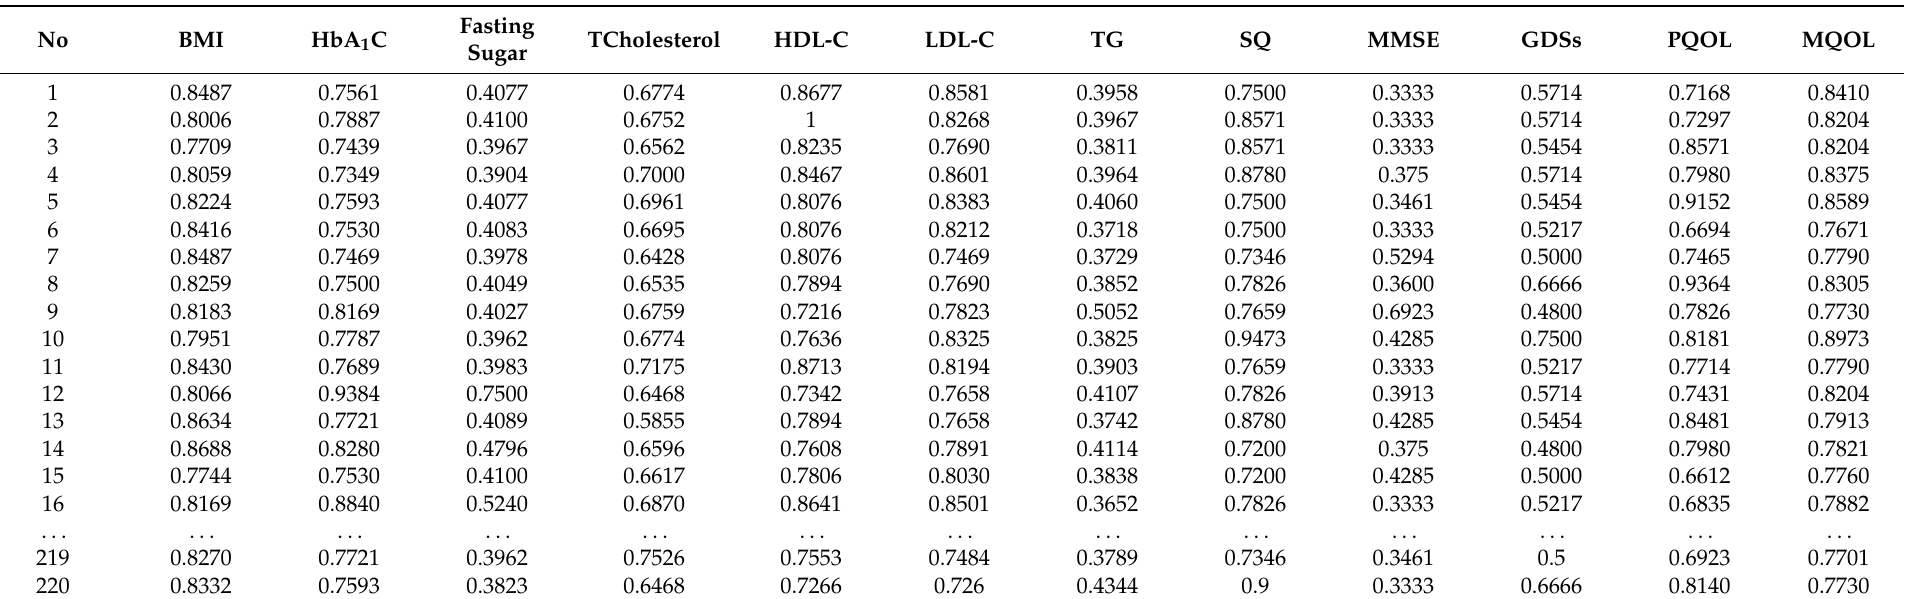
Table 3. Grey relational coefficient (GRC) ( n =